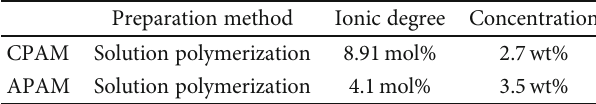
Table 1: Physical properties of polymer modi fi er.